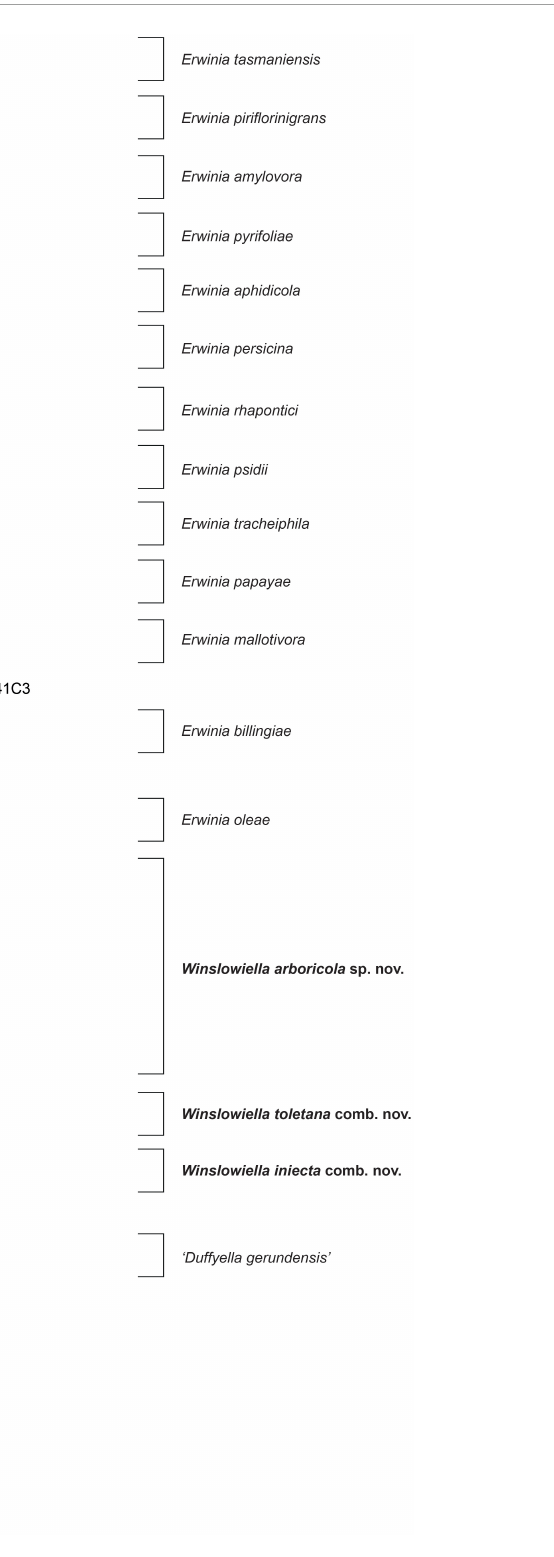
FIGURE1 Maximum likelihood tree based on concatenated partial gyrB , rpoB , atpD , and infB gene sequences of Winslowiella gen. nov., Winslowiella arboricola sp. nov., and phylogenetic relatives. Bootstrap values after 1,000 replicates are expressed as percentages (values > 50% shown). Cronobacter sakazakii (ATCC-BAA 894) is included as an outgroup. The scale bar indicates the fraction of substitutions per site. T , type